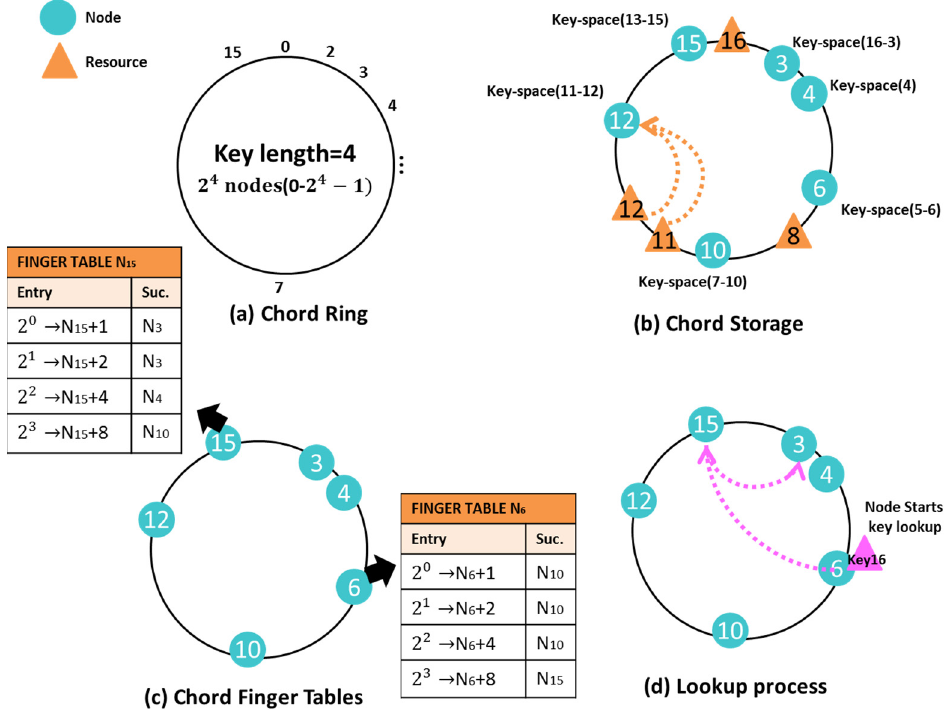
Figure 4. Chord protocol operation.